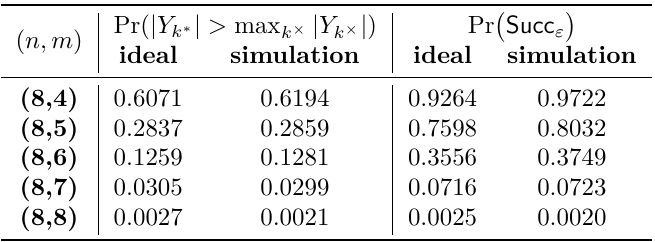
Table 1: The simulation and theoretical (ideal) analysis results for n = 8 , m = { 4 , 5 , 6 , 7 , 8 } by using AES-128 first round S-box as the selection function.